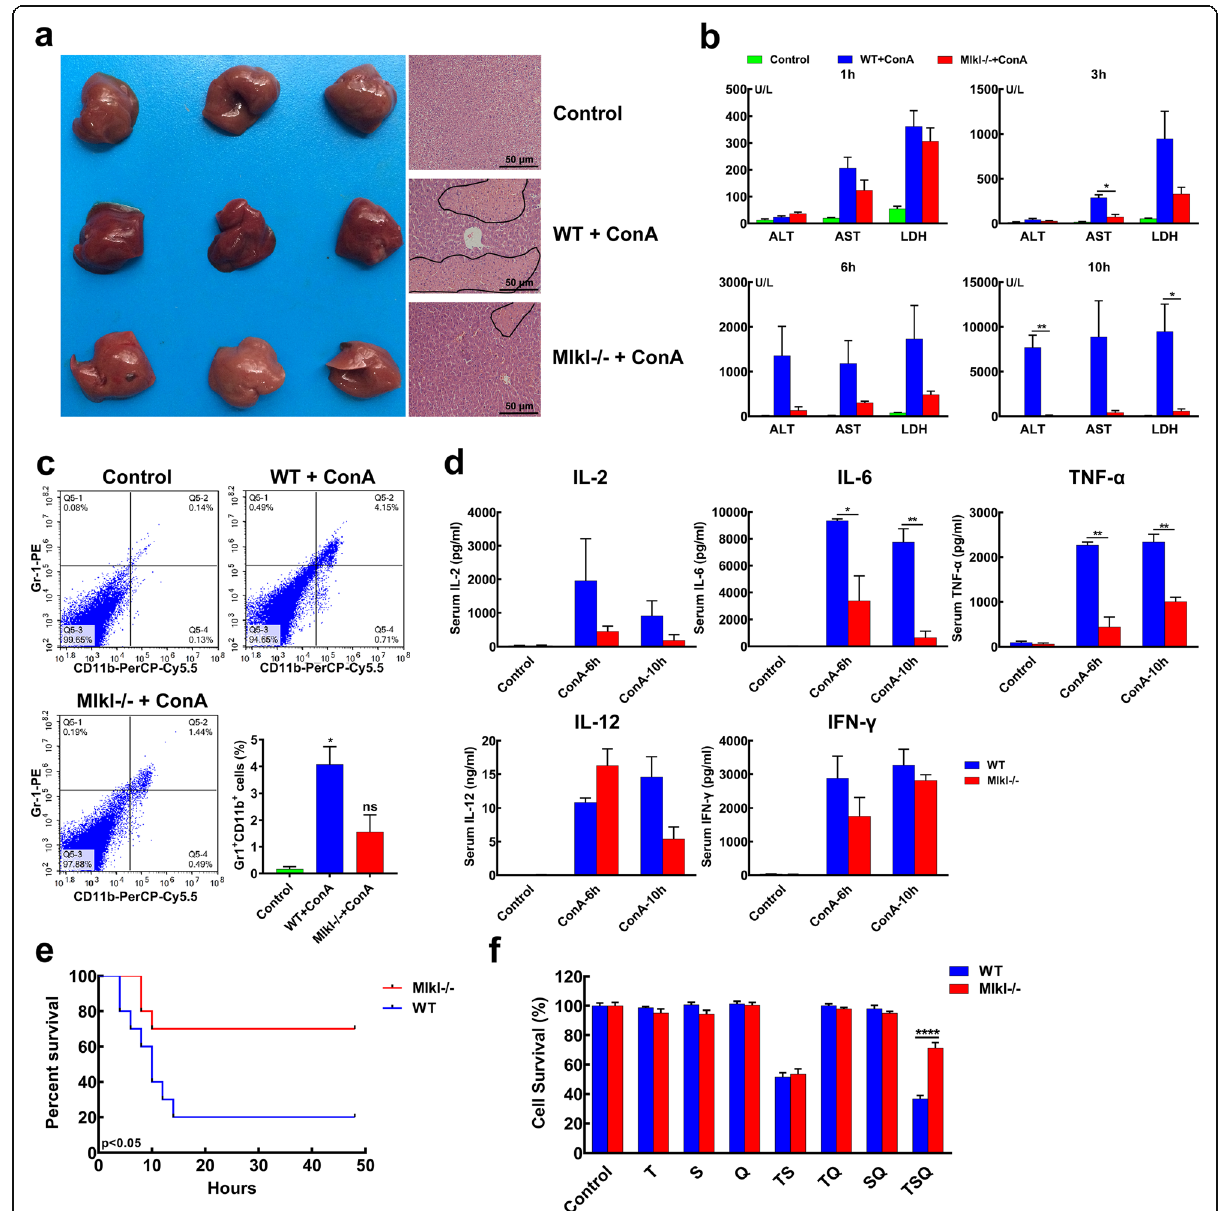
Fig. 3 MLKL may play a vital role in ConA-induced acute liver injury. a Representative photograph of mice liver from normal group, ConA-treated WT group and ConA-treated Mlkl − / − group, and HE staining of liver sections suggested obviously decreased ConA-induced hepatocyte necrosis in Mlkl − / − group than WT group. b Serum levels of ALT, AST and LDH were detected in normal mice, ConA-treated WT mice and ConA-treated Mlkl − / − mice at 1, 3, 6 and 10 h. c Gr1 + CD11b + cells were significantly increased in ConA-treated WT mice liver than that in ConA-treated Mlkl − / − mice liver. d The Mlkl − / − mice showed significantly lower IL-2, IL-6, IL-12, IFN- γ and TNF- α levels than WT mice at 6 and 10 h after ConA injection. e Survival curve of ConA-treated mice from WT group and Mlkl − / − group ( *p < 0.05 ). f Hepatocytes from Mlkl − / − mice could resist the necroptosis caused by the combination of hTNF- α (T), Caspase agonist analogue Smac (S) and caspase-inhibitor QVD-OPH (Q). (* p < 0.05, **p < 0.01, ****p <